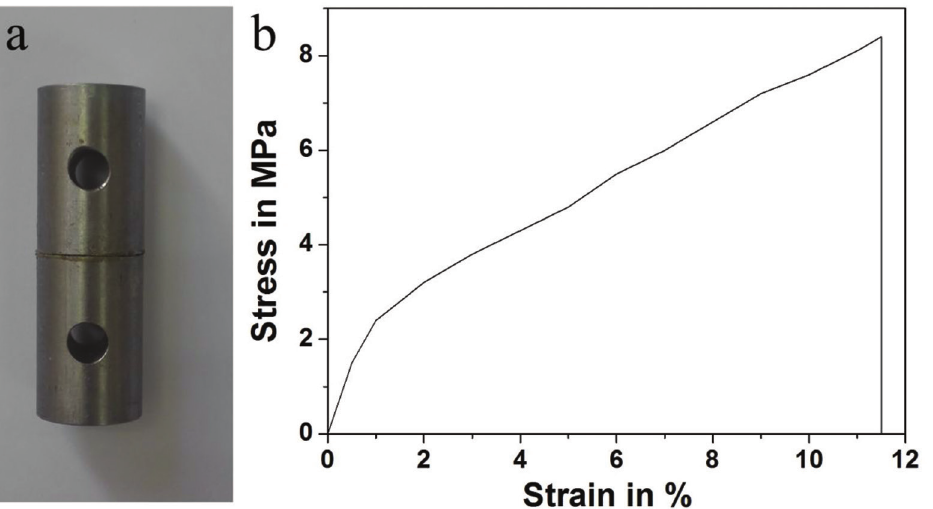
Figure 6: The jig photo (a) and the curve (b) of the coating adhesion between ZnO/TTCP/Gel coating and PET woven